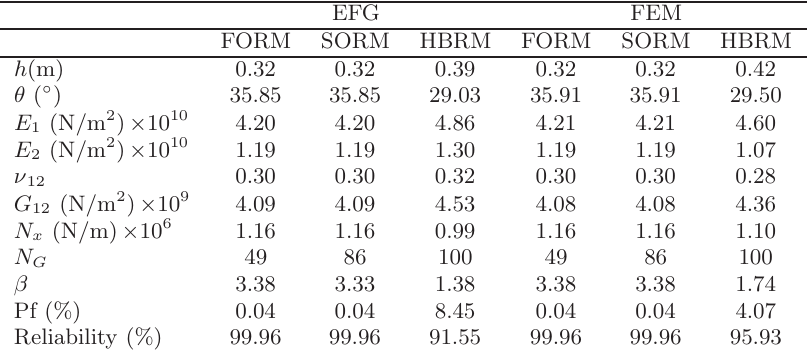
Table 5. Reliability analysis results, case 1.